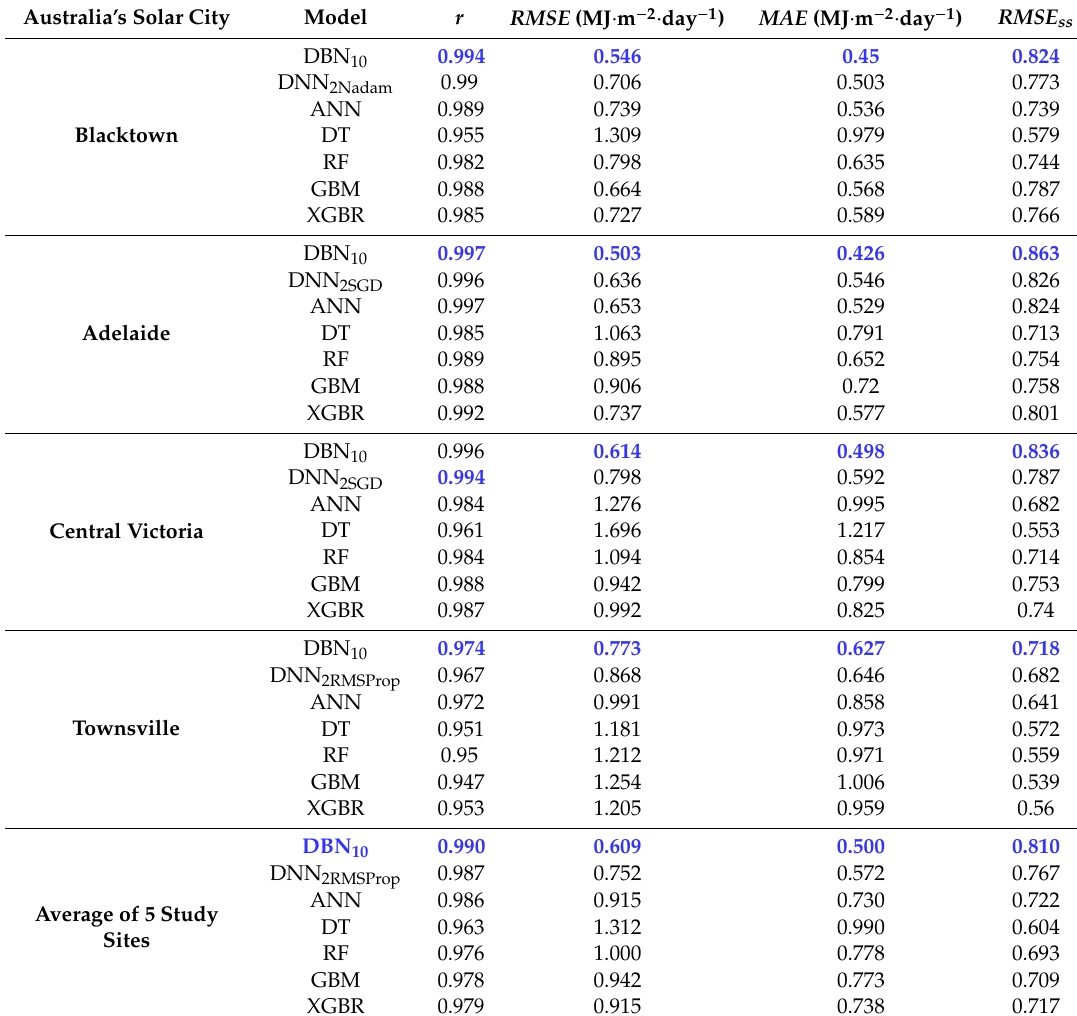
Table 7. Comparison of deep learning models vs. counterpart models. The best model is highlighted in blue and boldfaced (DBN 10 represents the optimal model, to accord with Table 3, and DNN 2 Nadam represents the optimal model, to accord with Table 5, trained with the Nadam-type back-propagation